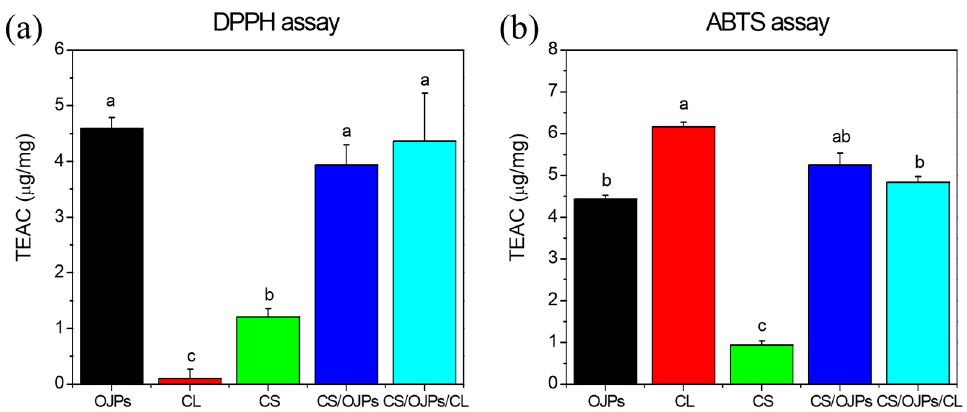
Figure 6. Antioxidant activity of CS/OJPs and CS/OJPs/CL NPs: ( a ) DPPH and ( b ) ABTS radicals scavenging activities. The different lowercase letters represent statistically significant differences ( p < 0.05).